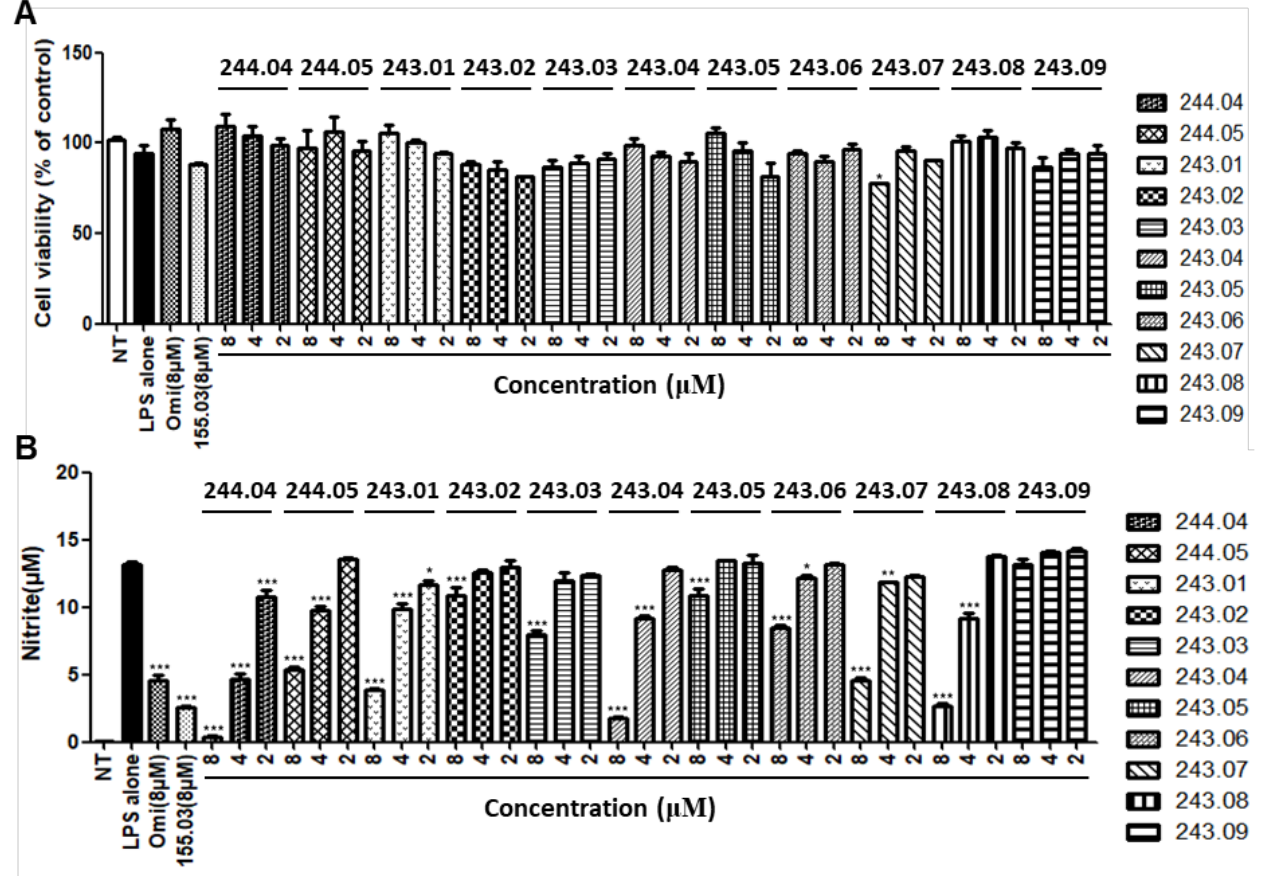
Figure 4. Screening of two selected WALK244 and all WALK243 peptides for immunomodulatory potential in Raw264.7 cells. Known anti-inflammatory peptides, WALK155.03 (8 µ M) and omiganan (Omi, 8 µ M), were compared as positive controls. All bar graphs represent the mean ± SEM of three independent experiments (* p < 0.05, ** p < 0.01, and *** p < 0.001, significantly different from the control group treated with LPS alone). Cytotoxicity ( A ) was assessed as cell viability, while the NO inhibitory effect ( B ) was deduced by measuring nitrite concentrations in the culture supernatants, as described in Figure